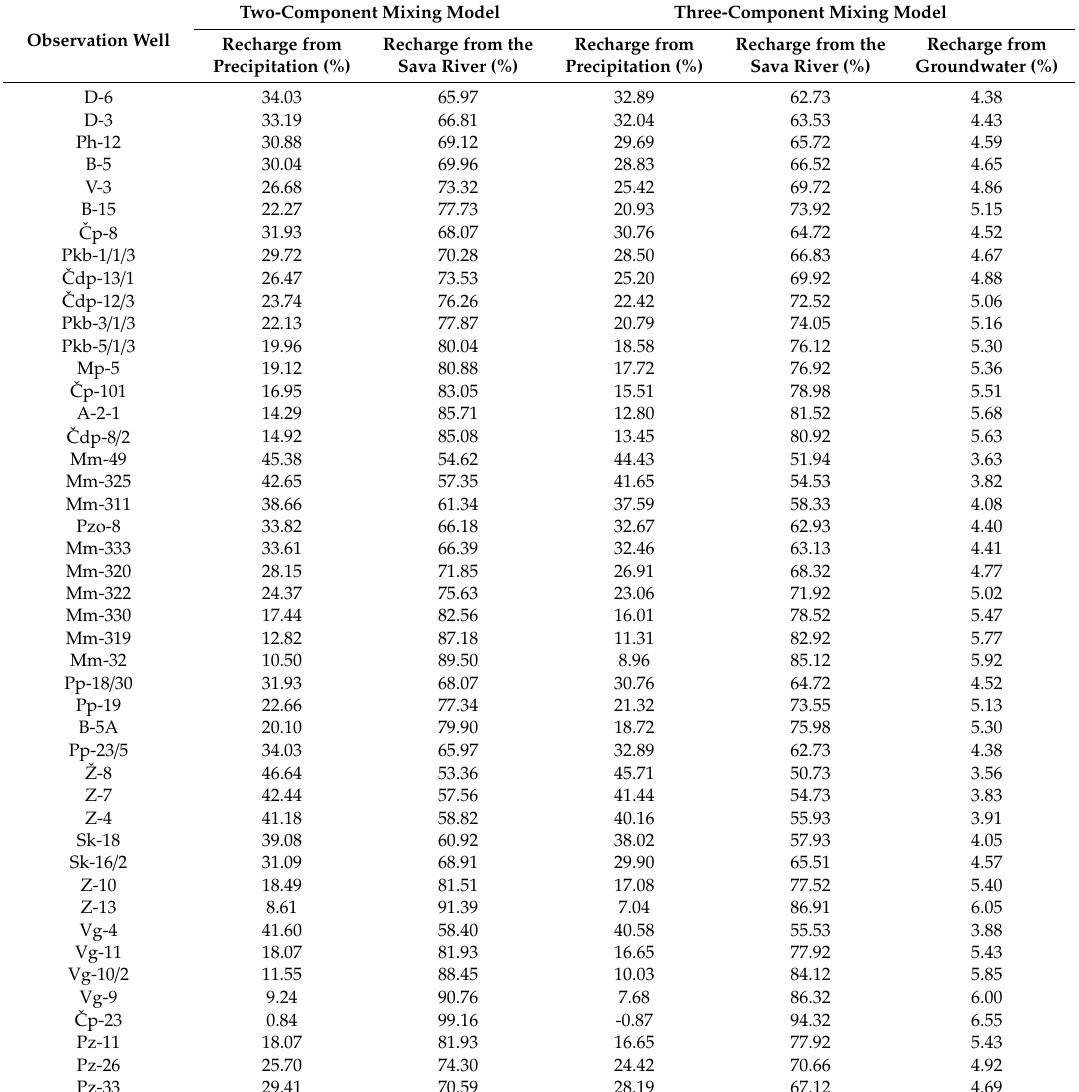
Table 3. Results of two- and three-component mixing